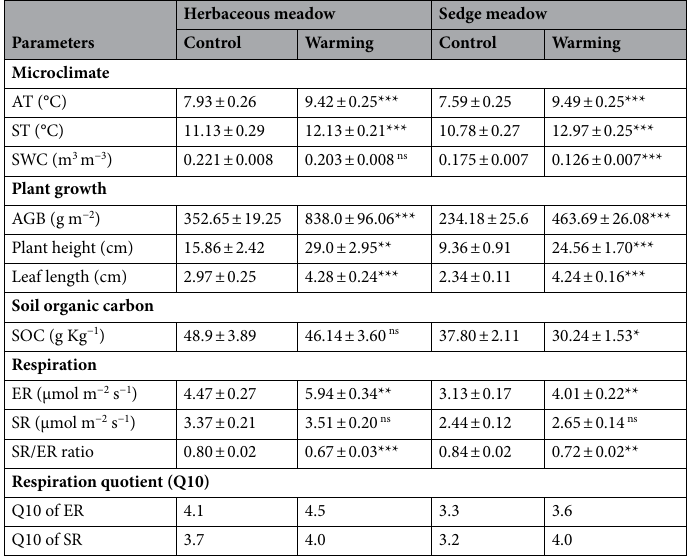
Table 1. Effects of experimental warming on various parameters in Herbaceous and Sedge Meadows across growing season. Values are mean ± S.E. Significant differences at p value * < 0.05, ** < 0.01 and *** < 0.001. ns reflects no significant difference. AT air temperature; ST soil temperature; SWC volumetric soil water content; AGB above ground biomass; SOC soil organic carbon; ER ecosystem respiration; SR soil